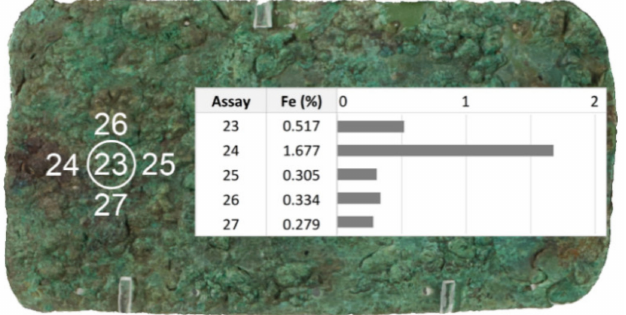
Figure 3. Location of cluster assay P004_4 (assays 23-27) on the right flap of P004 with values of